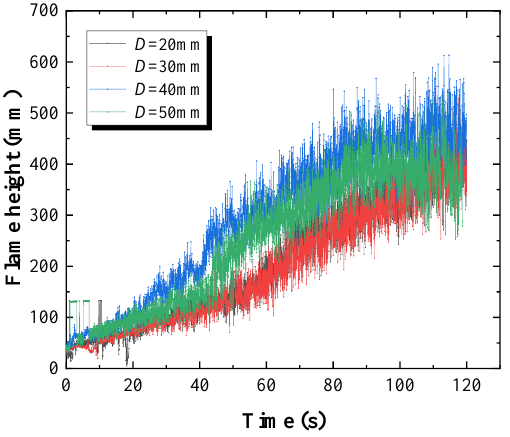
Figure 3. PMMA flame height versus time under different overlap lengths.